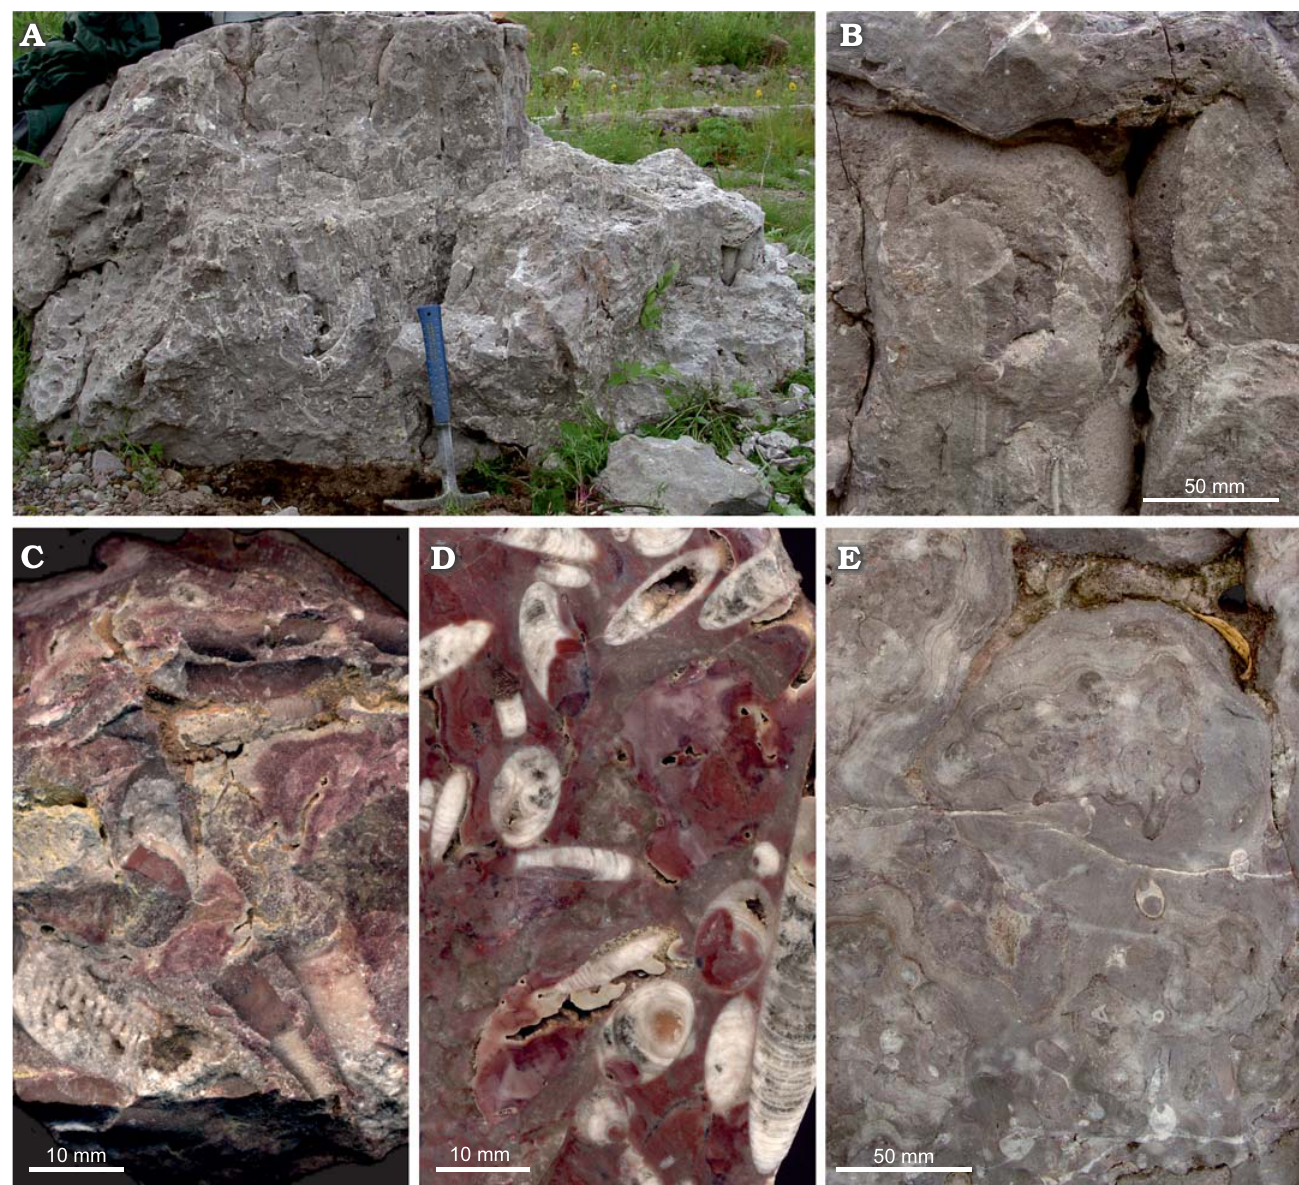
Fig. 1. Loose block No. 1 of a stromatolitic limestone with abundant nautiloid conchs of the Ust-kut Formation (latest Furongian or earliest Tremadocian) found on the left bank of the Angara River at the former village Pashino. A . The block partially exploited for fossils. B . Stromatolite columns with empty cavities and a laminar cover above. C . A piece of the rock with exposed nautiloids. D . Polished rock surface (note similarity of the specimen in the middle to the holotype of Ruthenoceras elongatum Korde, 1949). E . Naturally abraded upper surface of the stromatolite